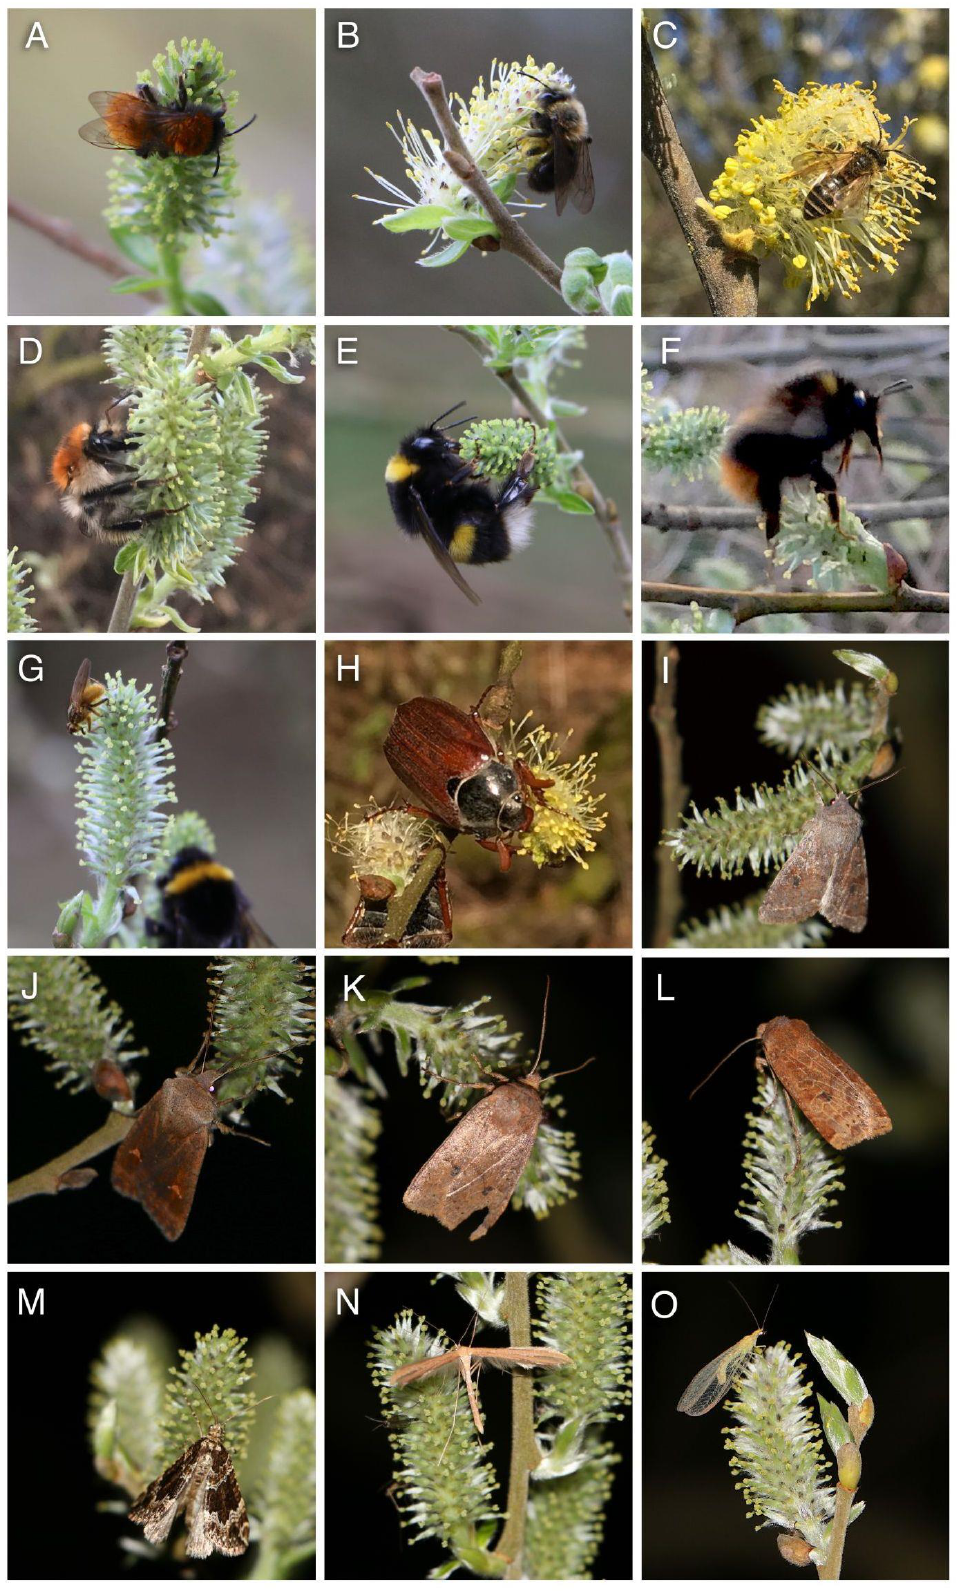
Figure 1. Flower visitors of Salix caprea : A: Andrena fulva , B: A. vaga , C: Colletes cunicularius , D: Bombus pascuorum (queen), E: B. lucorum (queen), F: B. pratorum (queen), G: Scathophaga stercoraria , H: Melolontha melolontha , I: Orthosia incerta , J: Eupsilia transversa , K: Conistra vaccinii , L: Agrochola circellaris , M: Epirrhoe alternata , N: Pterophoridae sp., O: Chrysoperla carnea . All photos taken by K. Ohashi (A – H = diurnal, I – O =